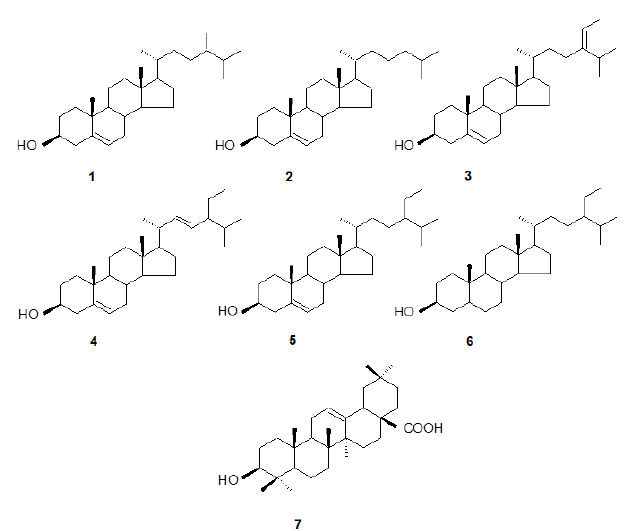
Figure 1. The structures of compounds identified in Calendula officinalis hairy root cultures (CC16 and CH2 lines). ( 1 ) campesterol, ( 2 ) cholesterol, ( 3 ) isofucosterol, ( 4 ) stigmasterol, ( 5 ) sitosterol, ( 6 ) sitostanol, ( 7 ) oleanolic acid.